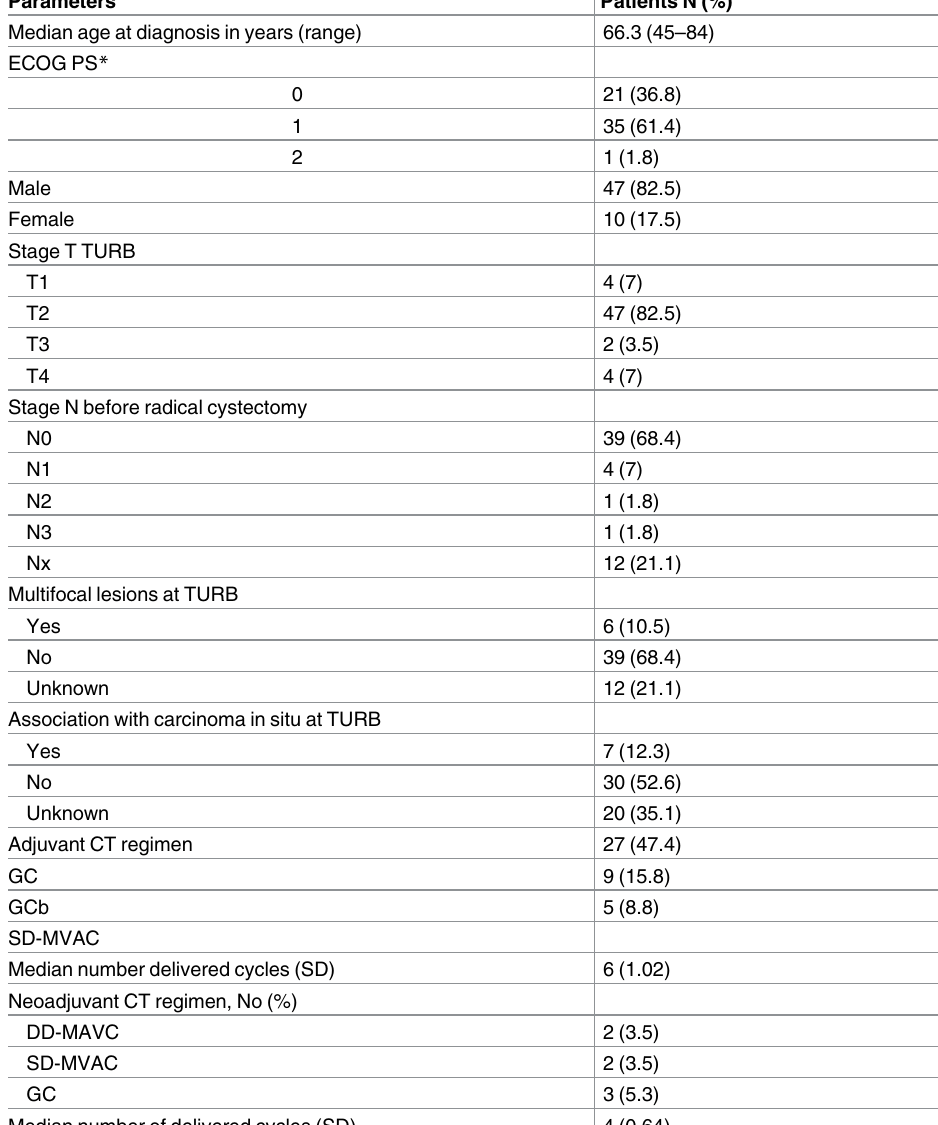
Table 1. Clinico-pathological data and perioperative chemotherapy schedules for patients treated by radical cystectomy and adjuvant radiotherapy. Parameters Patients N